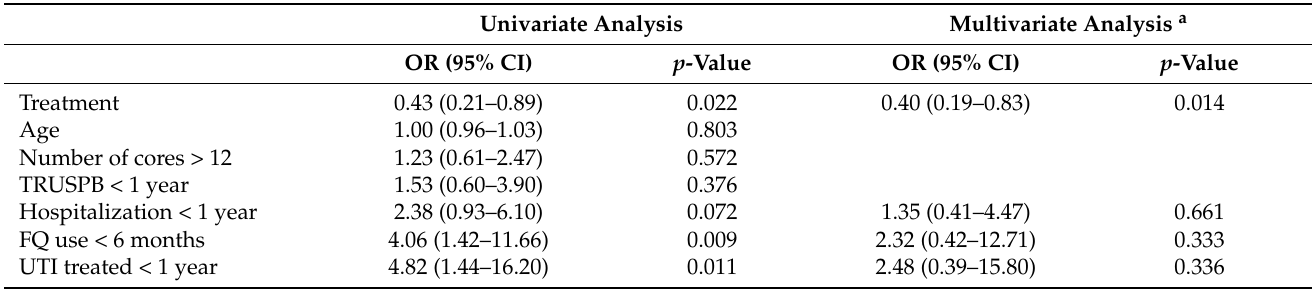
Table 2. Univariate and multivariate logistic regression analysis for association with infectious compli-